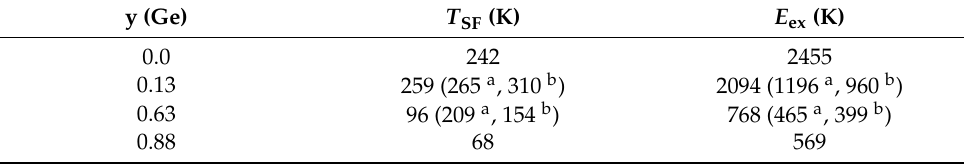
Figure 2. Thermoelectric power as a function of temperature fitted with Equation (5). ( a ) y = 0.0, ( b ) y = 0.13, ( c ) y = 0.63, ( d ) y = 0.88. The obtained values of the parameters are gathered in Table 1. S ( T ) measurements were described in Ref. [16]. Table 1. Spin fluctuation temperature T SF and interconfigurational excitation energy E ex for thermoelectric power of CeNi 2 (Si 1 − y Ge y ) 2 analyzed by Equation (5) (with T eff = T + T SF ).